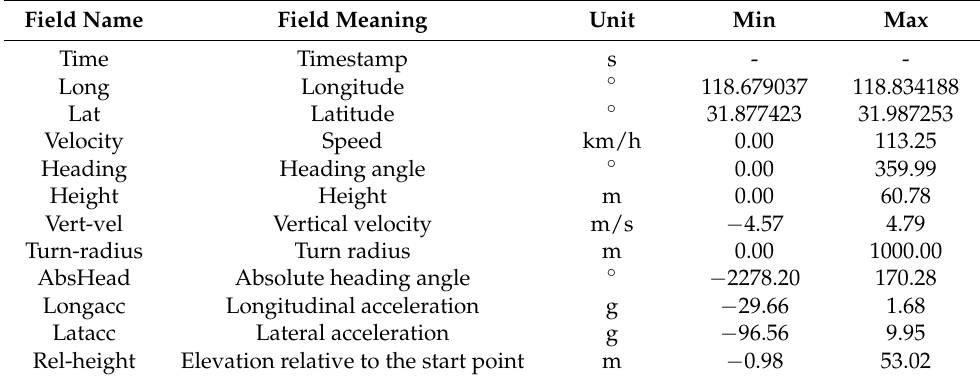
Table 1. Description of Vehicle Kinematic Data.